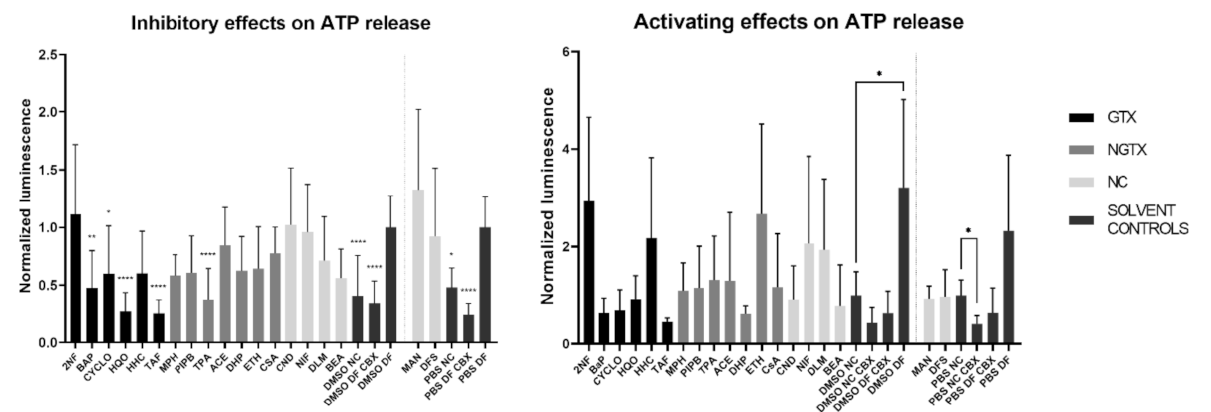
Figure 12. Inhibitory effect or activating effect of GTX, NGTX and NC chemicals on connexin hemichannel-related ATP release in human hepatoma HepaRG cells. Human hepatoma HepaRG cells ( n = 2–3 and N = 4) were exposed to GTX, NGTX and NC chemicals for 72 h, after which the ATP release assay was performed. DF buffer was used to open the hemichannels, while CBX was used as an inhibitor. Luminescence was measured and data were normalized by the mean luminescence of their respective DF solvent control (assessment of inhibitory effects) or NC solvent control (assessment of activating effects). Significant difference to the respective DF solvent control or NC solvent control was calculated with a non-parametric Kruskal-Wallis test followed by a Dunn’s multiple comparison test. Data are expressed as mean ± standard deviation with * p ≤ 0.05 ** p ≤ 0.01 and **** p ≤